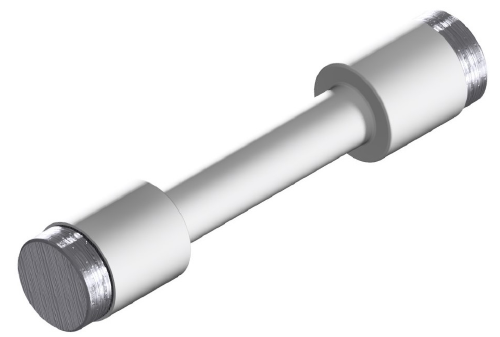
Figure 8. 3D model of the rotor used in the test bench.